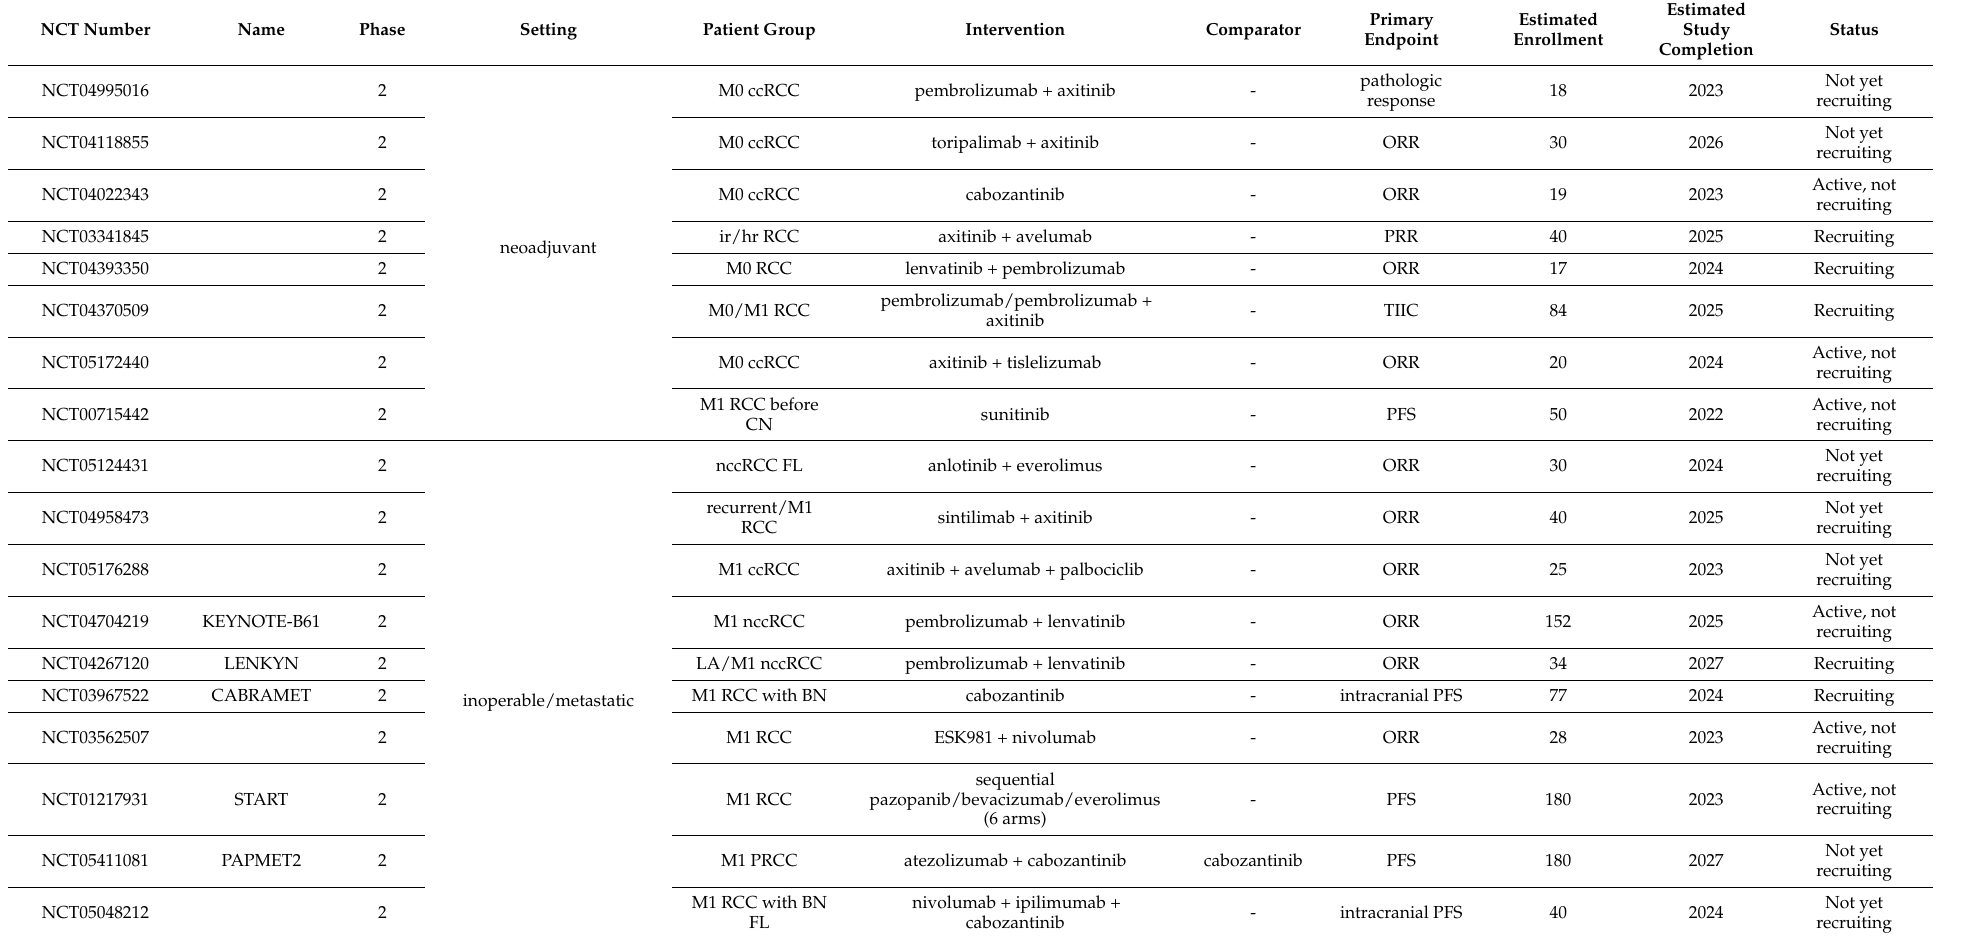
Table 2. Ongoing trials including TKI for renal cell carcinoma. Trials with established therapies concerning setting and histopathological subtype were excluded, while phase I/II trials were